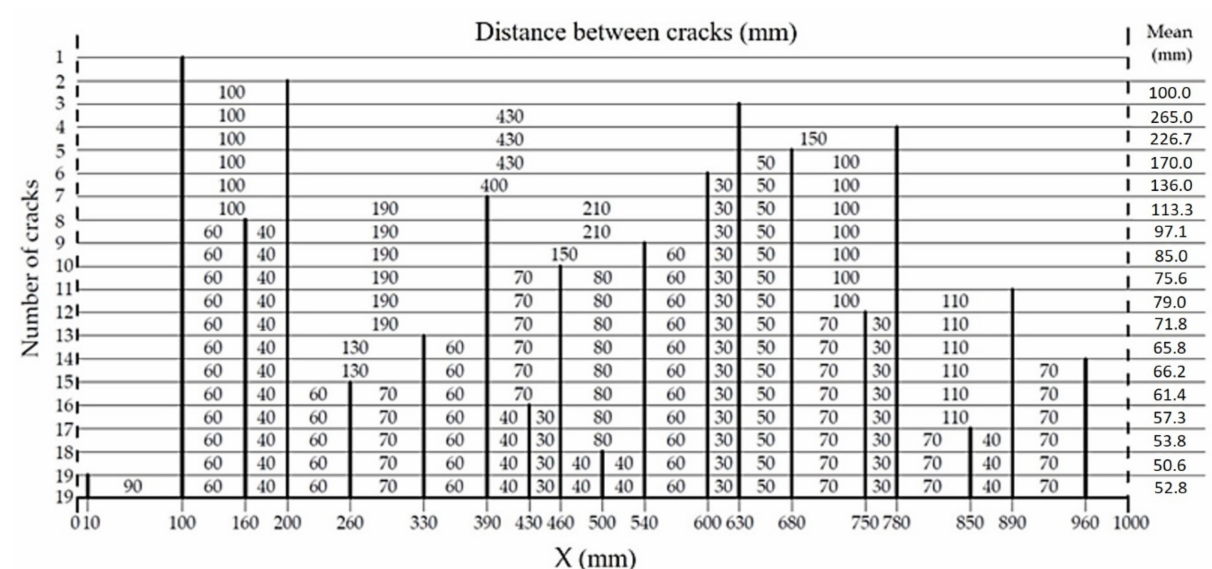
Figure 23. Crack formation and density under loading—beam A2M-2.